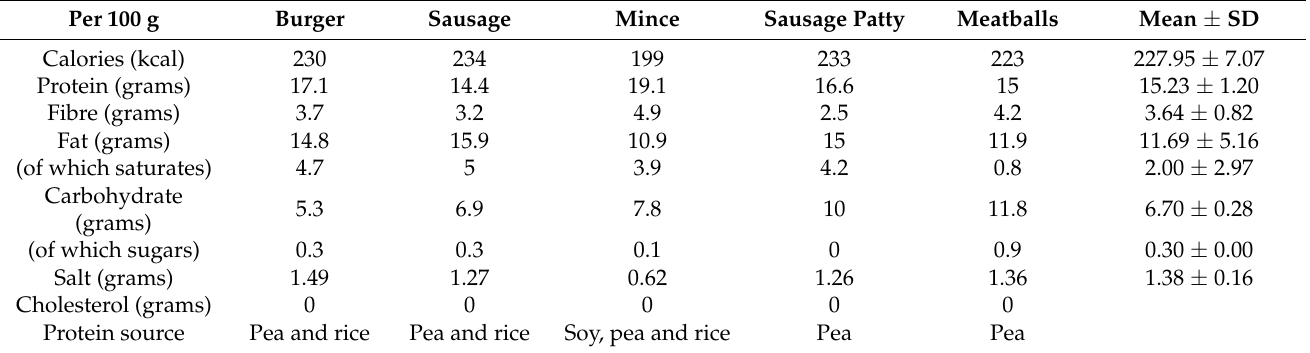
Table 1. Intervention products’ macronutrients and protein